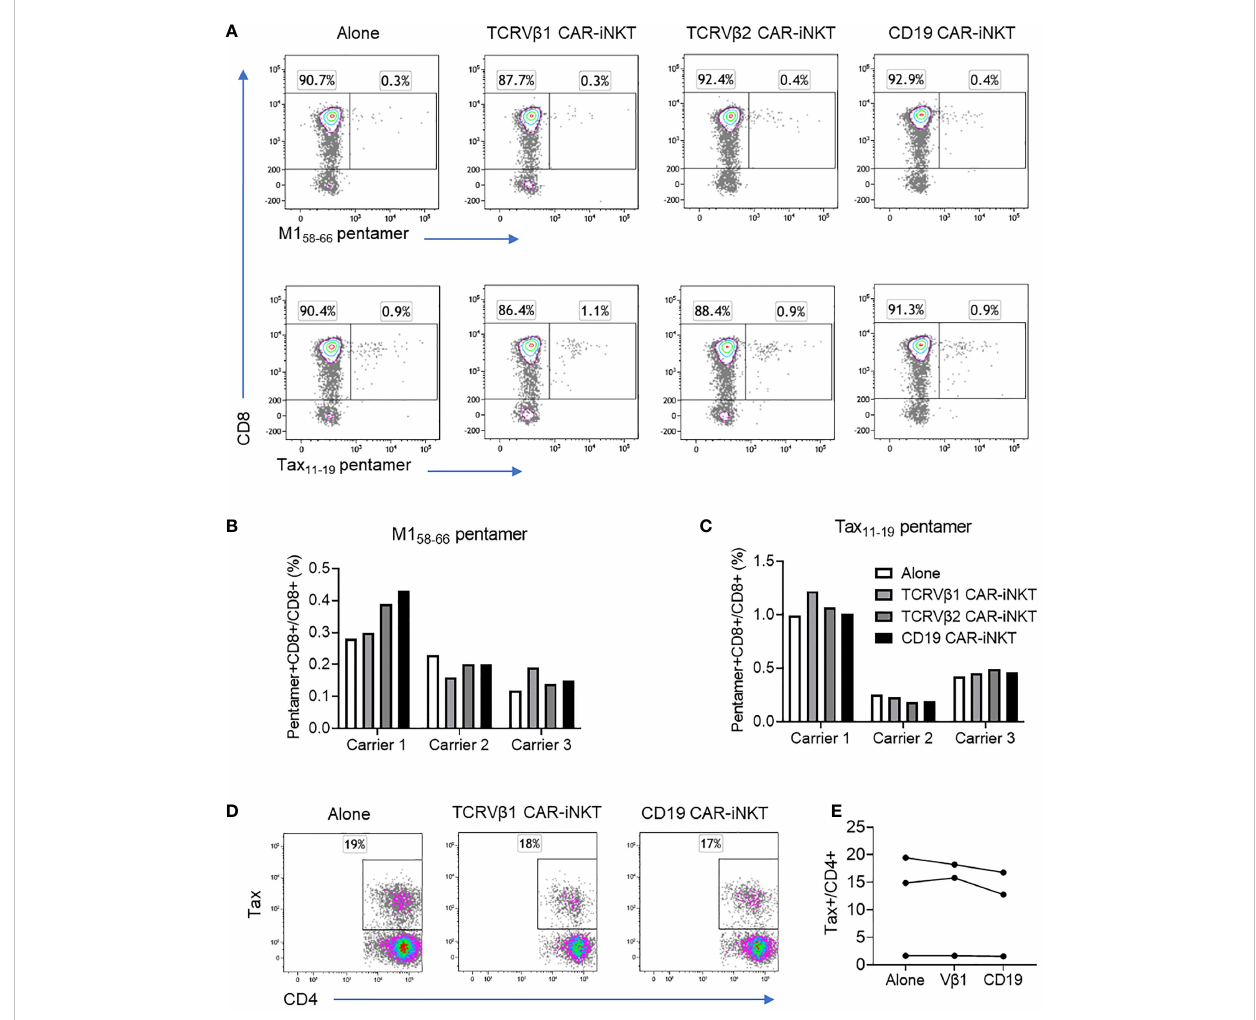
FIGURE 4 Effect of CAR-iNKT on the frequency of antiviral CTL and HTLV-1 expressing CD4+ T cells. (A – C) Frequency of M1 58-66 and Tax 11-19 HLA-A*0201 pentamer+CD8+ T cells after co-culture with CAR-iNKT. CD4-depleted PBMC from three HLA-A*0201+ HTLV-1 carriers were stained with CellTraceViolet and were cultured alone or with an 1:1 ratio of anti-TCRV b 1 -V b 2 or -CD19 CAR-iNKT. After 16-18h co-culture, cells were stained with a viability stain, and anti-CD3, -CD8 antibodies and M1 58-66 or Tax 11-19 pentamers. Cells were analysed by fl ow cytometry and the frequency of live Pentamer+CellTraceViolet+CD3+CD8+ cells was determined. (D, E) Frequency of HTLV-1 Tax expressing CD4+ cells after co-culture with CAR- iNKT. CellTraceViolet stained, positively selected CD4+ cells from the same donors were cultured alone or in the presence of V b 1- V b 2- or CD19- CAR iNKT. After 16-18h, cells were stained with a viability stain, anti-CD3,-CD4, -CD8 and -TCRV b 1 or -TCRV b 2. Cells were subsequently fi xed, and stained intracellularly with anti-Tax antibody. Cells were analysed by fl ow cytometry and the frequency of live TCRV b 1/2+CD3+ cells and live Tax +CD4+ cells were